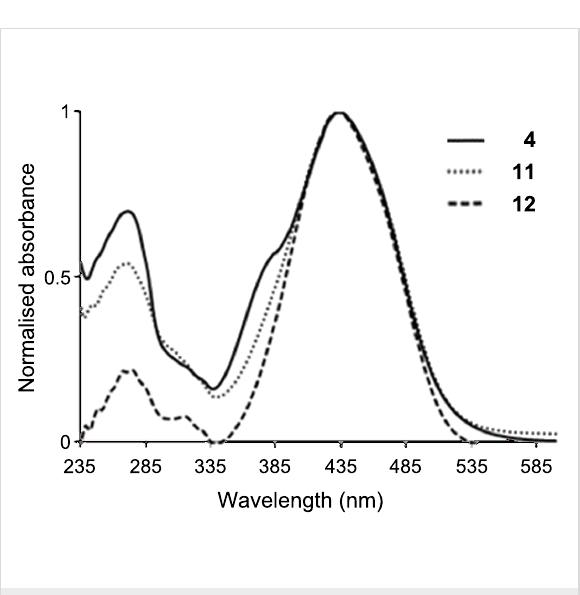
Figure 1: UV–vis spectra of compounds 8 – 10 .